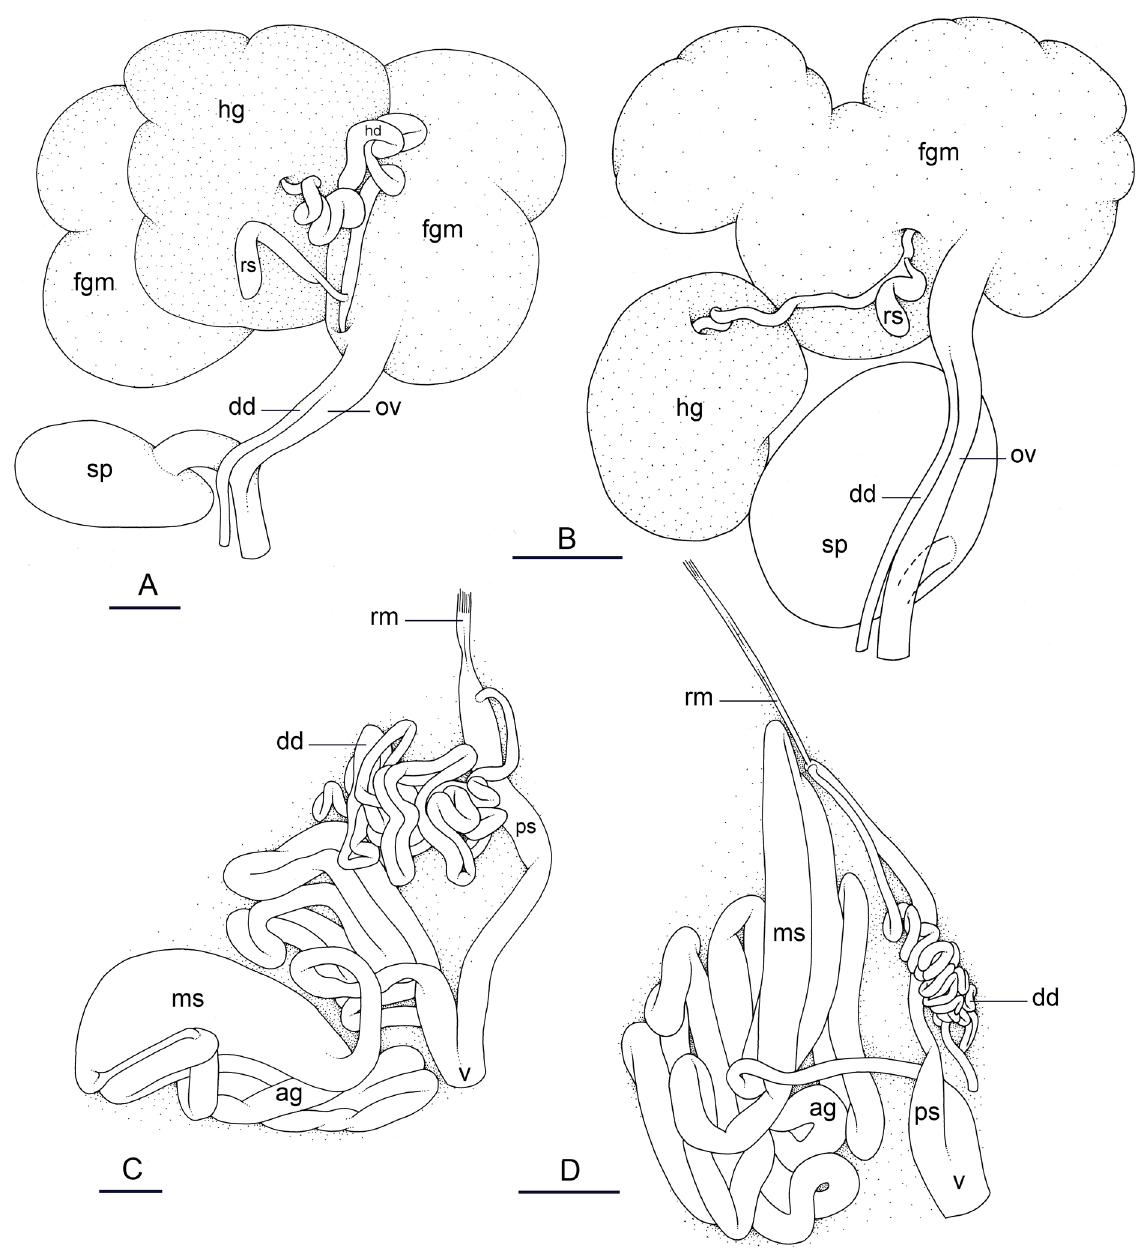
Fig. 17. Paromoionchis tumidus (Semper, 1880) comb. nov., reproductive system. A . Unit #3, posterior hermaphroditic (female) reproductive system, Papua New Guinea, Madang [5433] (MNHN IM- 2013-10479). B . Unit #2, posterior hermaphroditic (female) reproductive system, Australia, Northern Territory [1638] (NTM P.57623). C . Male copulatory organs, same as A. D . Male copulatory organs, same as B. Abbreviations: ag = accessory penial gland; dd = deferent duct; fgm = female gland mass; hd = hermaphroditic duct; hg = hermaphroditic gland; ms = muscular sac (of accessory penial gland); ov = oviduct; ps = penial sheath; rm = retractor muscle; rs = receptaculum seminis; sp = spermatheca; v = vestibule. Scales: A, C = 1 mm; B, D = 3